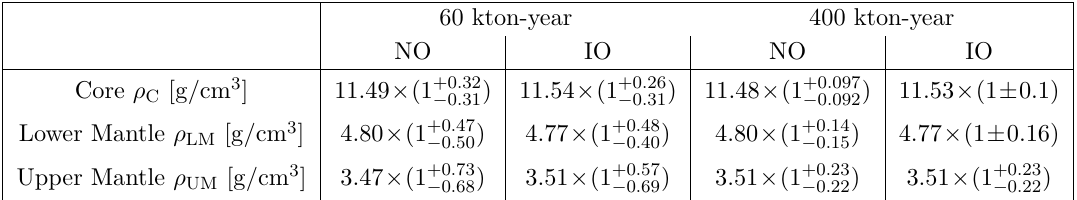
Table 3 . DUNE sensitivity on the measurement of the core, lower and upper mantle densities after applying the Earth’s mass and moment of inertia constraints assuming two different values of the experimental